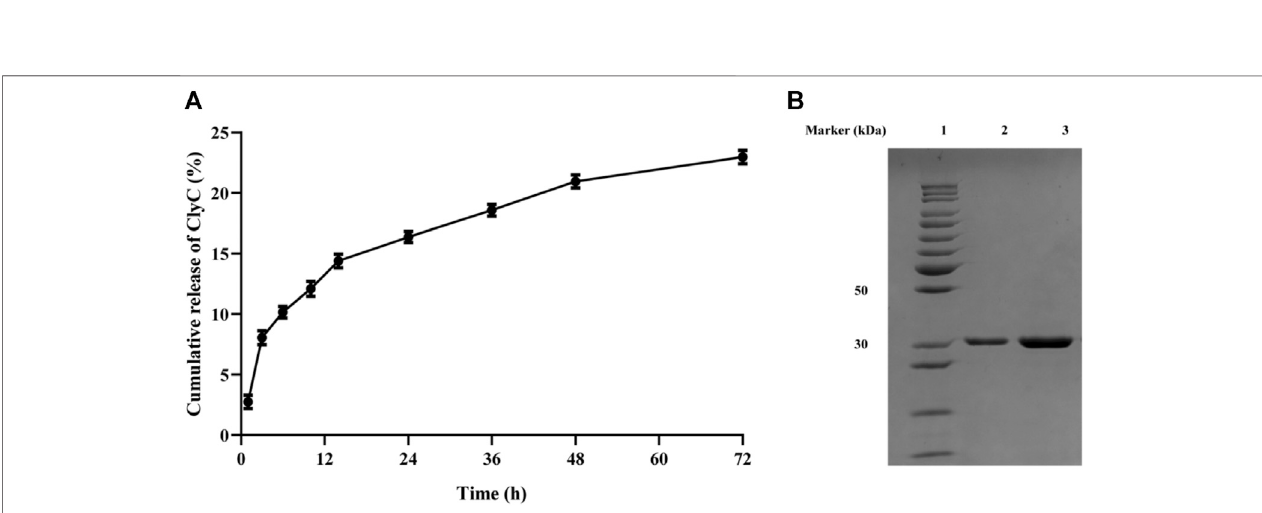
FIGURE4| Invitro releaseofClyCfromhydrogelat37 ° CinTrisbuffer. (A) ThecurveofpercentreleasedClyCatdifferenttimeintervals.Mean ± SD, n (cid:2) 3; (B) SDS- PAGEoffreeClyC and ClyC released from hydrogel todetermine the structural integrityofendolysin after encapsulation. Lane 1: Standard Protein Marker. Lane 2: ClyC released from the hydrogel. Lane 3: ClyC free native